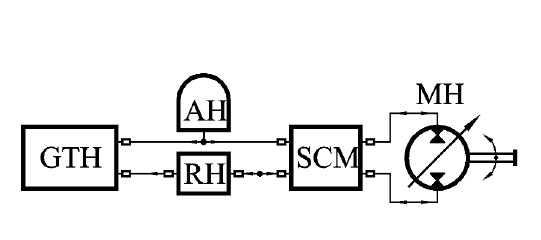
engine cycle) and automatic functioning on the START- STOP principle that means there is an automatic start when the energy (pressure) in the accumulator has the minimum admissible value and an automatic stop when the energy pressure) in the accumulator has the maxi- mum admissible value. The hydraulic accumulator is of hydro-pneumatic type. The accumulator has the role to accumulate the energy produced by the thermal-hydraulic generator that is necessary to run the resistant strokes of the engine cycle and to supply the hydraulic motor (mo- tors). What is more, the accumulator has the role to